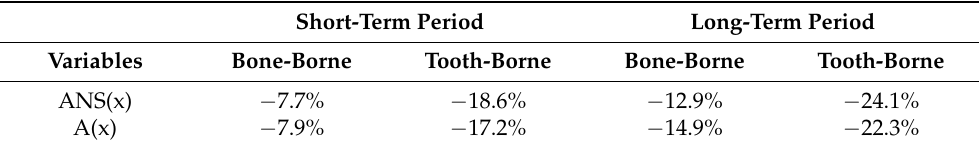
Table 7. The horizontal relapse rate in ANS(x) and A(x) in short-term and long-term follow-up. Short-Term Period Long-Term Period Variables